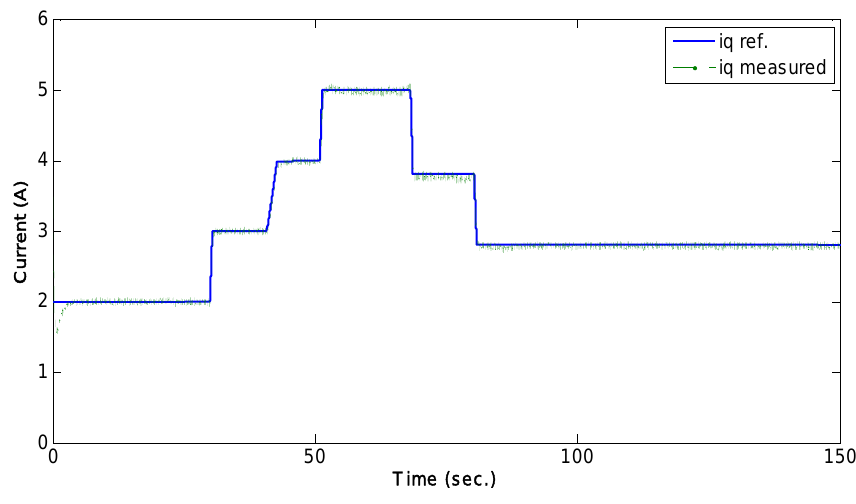
Figure 15. Response of the controlled rotor q